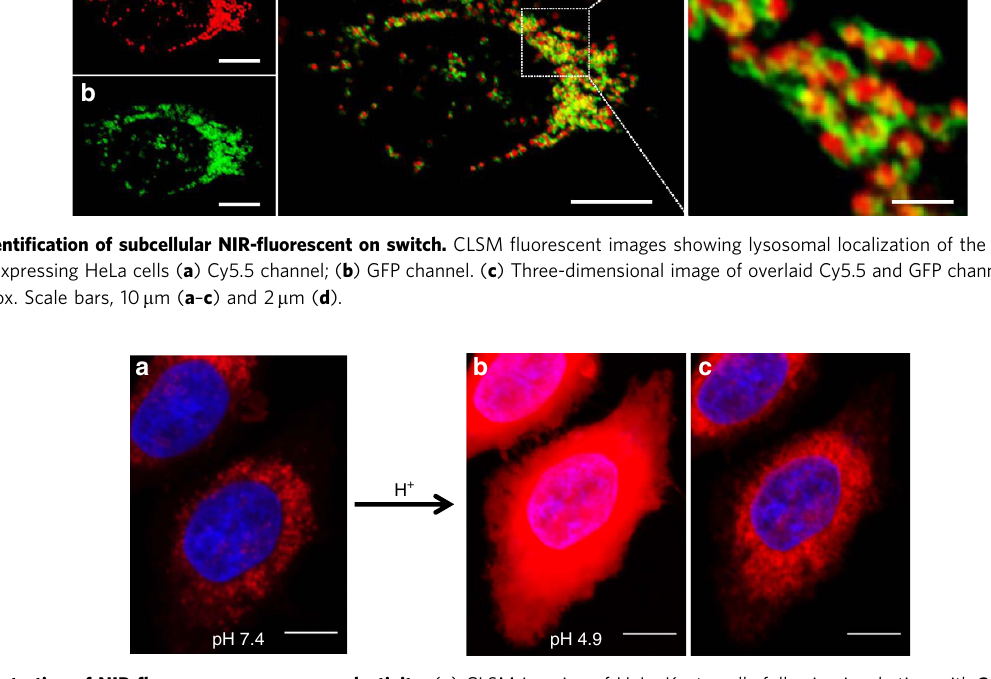
Figure 7 | Illustration of NIR-fluorescence response selectivity. ( a ) CLSM imaging of HeLa Kyoto cells following incubation with 2 (10 m M) for 2h at 37 (cid:2) C, DAPI nuclei staining and fixing. ( b ) The same set of cells imaged after buffer changed to pH 4.9, keeping the same laser power and PMT voltage. ( c ) The same set of cells after adjustment of microscope laser power and PMT voltage to obtain a non-saturated image. Red: 2 ; blue: DAPI stain. Scale bar, 10 m